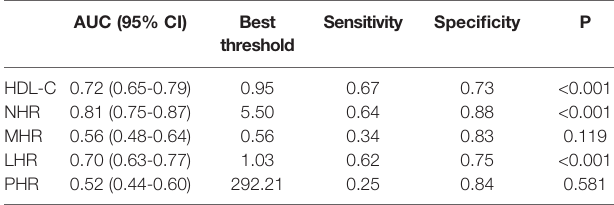
TABLE 4 | Diagnostic values of serological indicators in assessment adverse outcome of